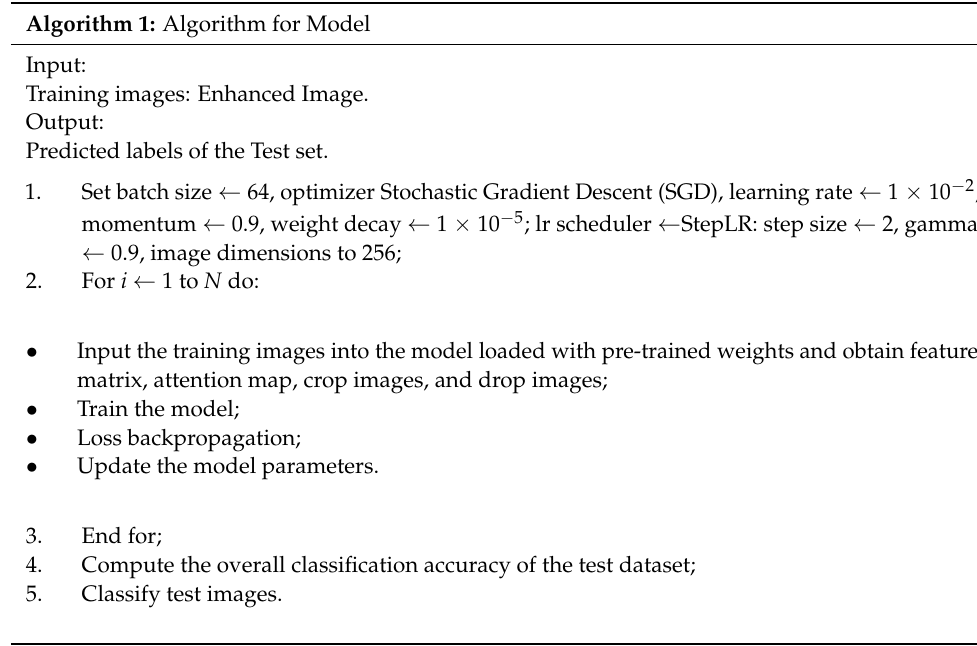
Figure 4. Coordinate attention-guided data enhancement image generation process, where CNN denotes Convolutional Neural Network, DBAM denotes dual bilinear attention module.